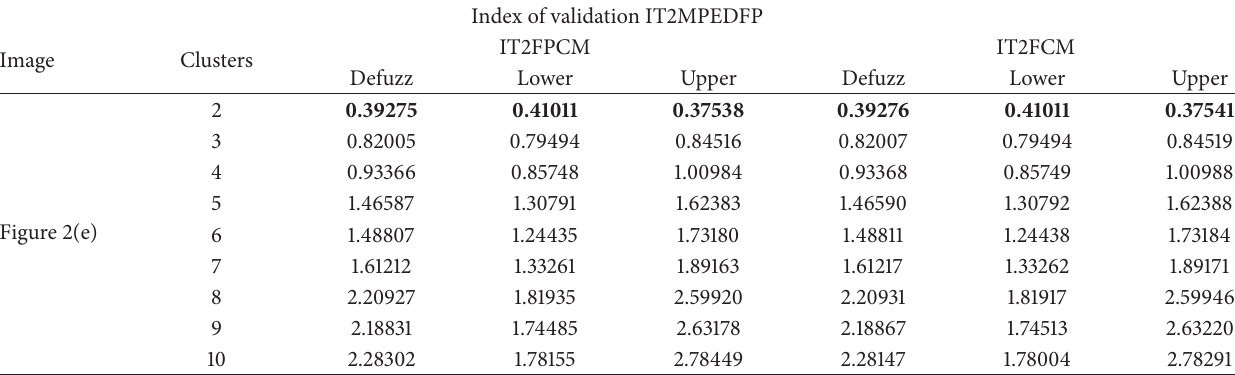
Table 41: Results of the IT2MPE-DMFP validation index to data clustering of image shown in Figure 2(e) using IT2FPCM and IT2FCM algorithm with 𝑚 = [1.5, 2.5] and 𝜂 = [1.5, 2.5] as